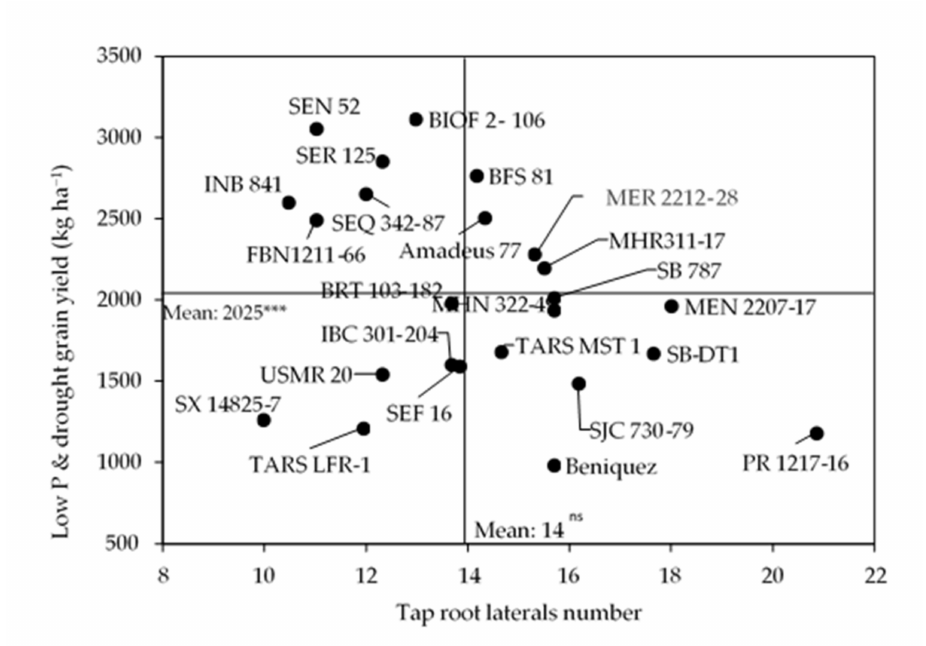
Figure 4. Genotypes with greater yield and higher values of taproot lateral number grown under low P and drought treatment. The outstanding genotypes with higher yield and greater taproot branching are in the upper right quadrant. *** — significant ( p = 0.001) and ns — non-significant ( p > 0.05).